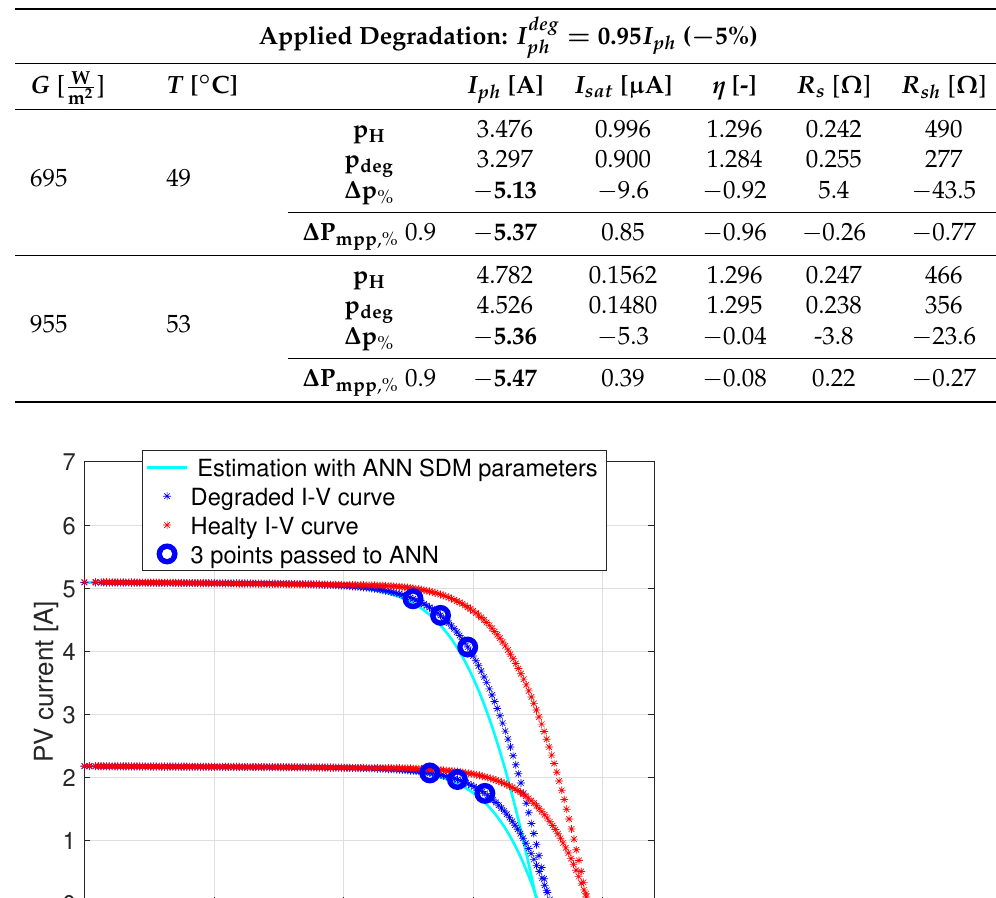
Figure 13. ANN identification of degraded curve with − 5% of variation on I ph for two different irradiance and temperature conditions. Table 5. SDM parameters estimated with ANN for I - V curves of Figure 13.